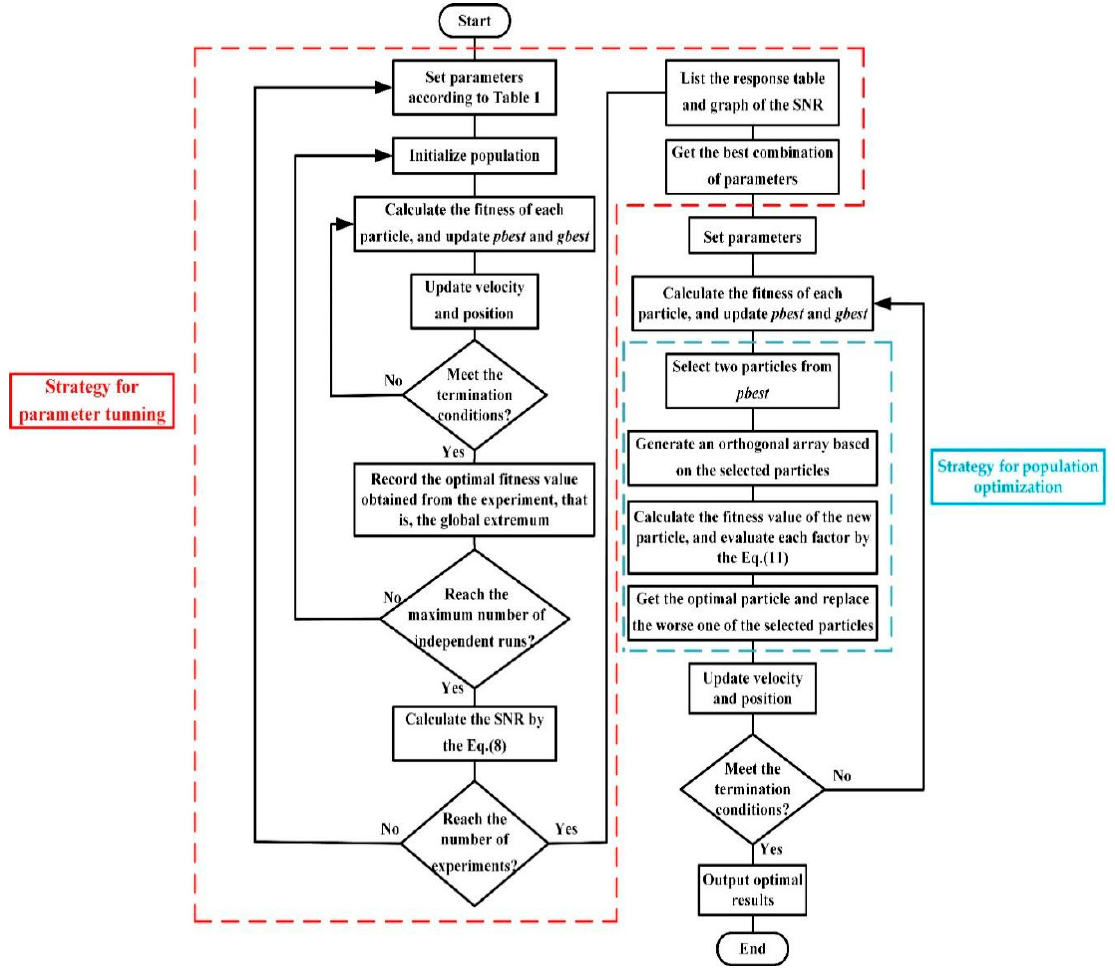
Figure 1. HTPSO algorithm flowchart.